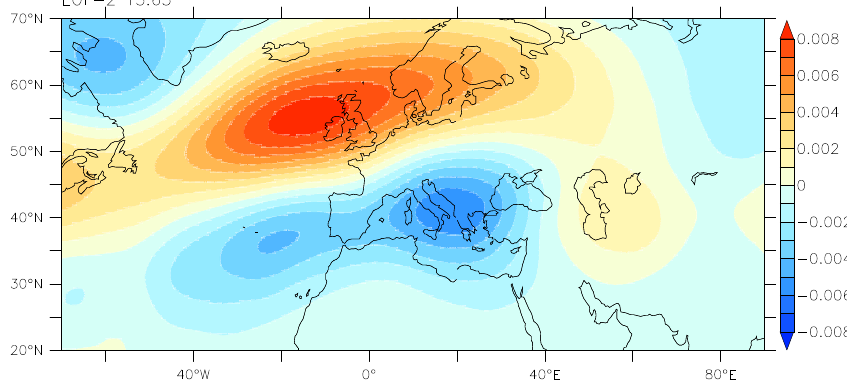
Fig. 5 Atlantic-Eurasian Rossby wave. The second leading EOF of JJAS 200-hPa GPH anomalies (shaded).